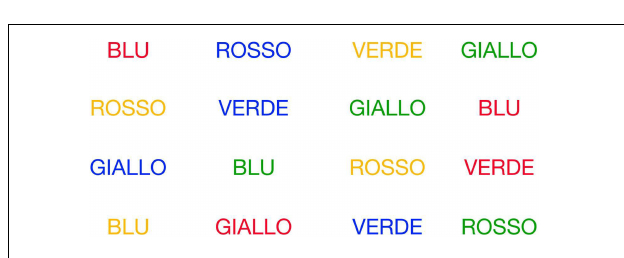
FIGURE 2 | Reading With Interferences